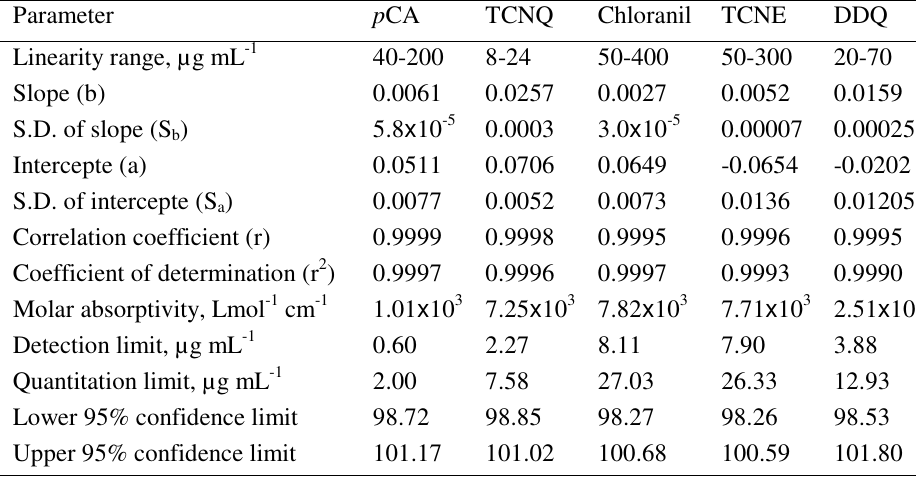
Table 2 . Comparative parameters for the charge-transfer reaction of pregabalin with various acceptors